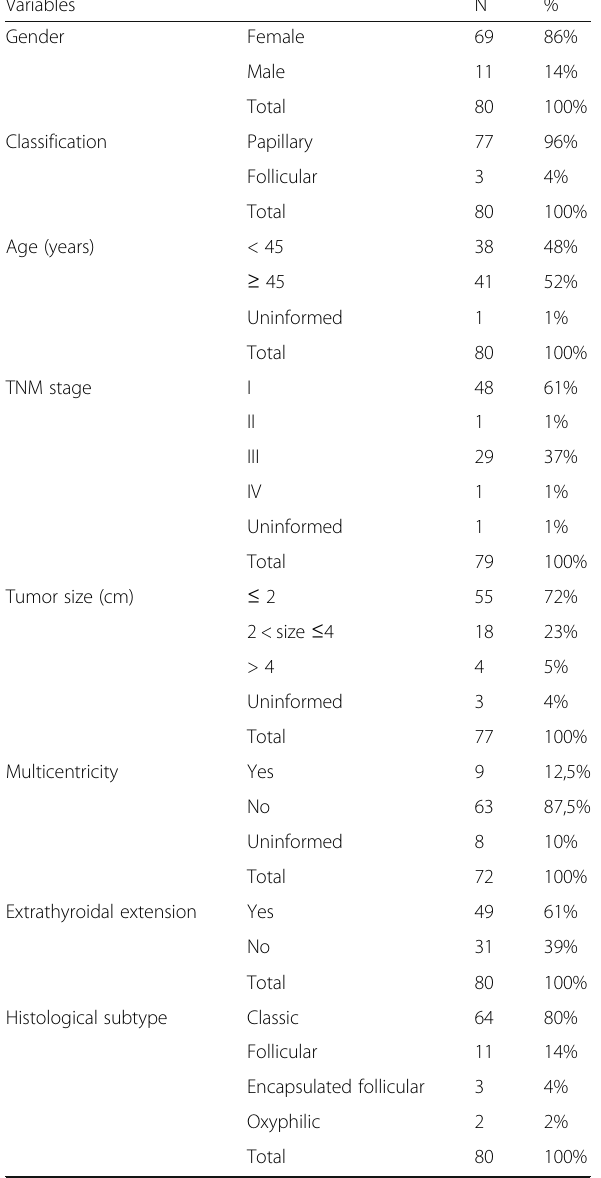
Table 1 Clinical and pathological characteristics of